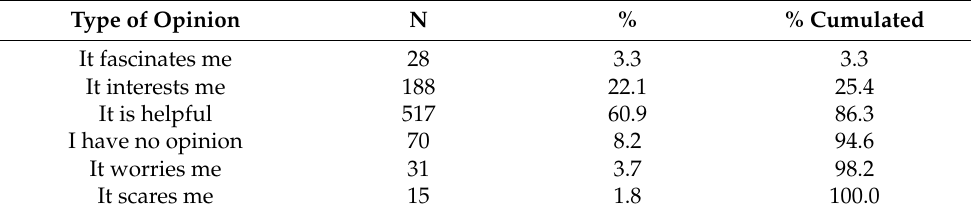
Table 6. Nurses’ opinions on the presence of new technologies in the lives of modern people.